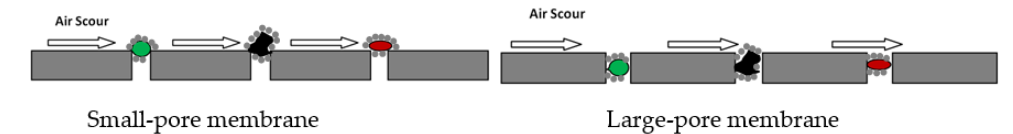
Figure 3. Schematic of pore blocking on small-pore and large-pore membranes.